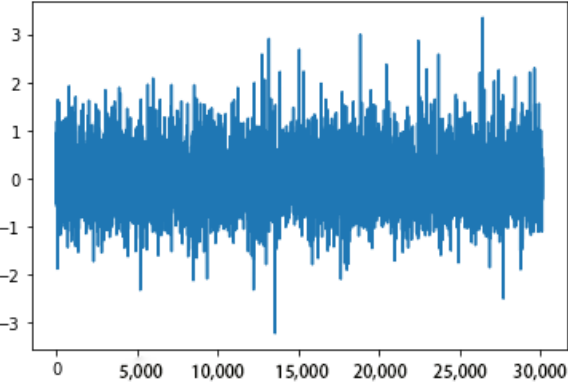
Figure 9. Partial estimation error before filtering.